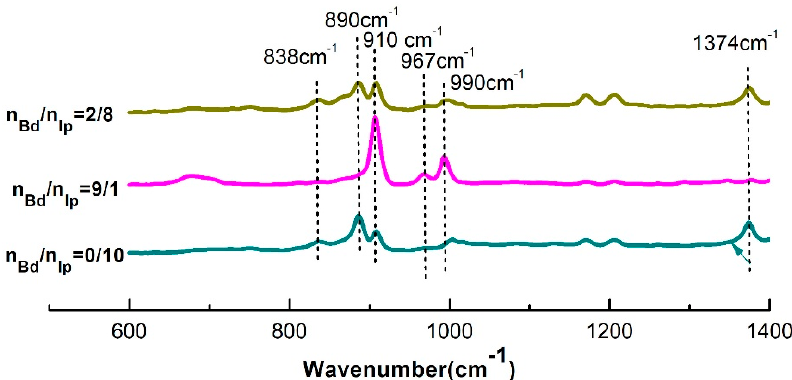
Figure 9. FTIR spectra of the resulting copolymers fabricated by coordination polymerization at the Bd:Ip mole ratios of 2:8, 9:1 and 0:10, respectively. Polymerization conditions: TNPP:Mo = 6, [M] = 0.18 g ∙ mL − 1 , Al:Mo = 5, T = 60 °C, Mo:[M] = 8 × 10 − 4 , t = 7 h.